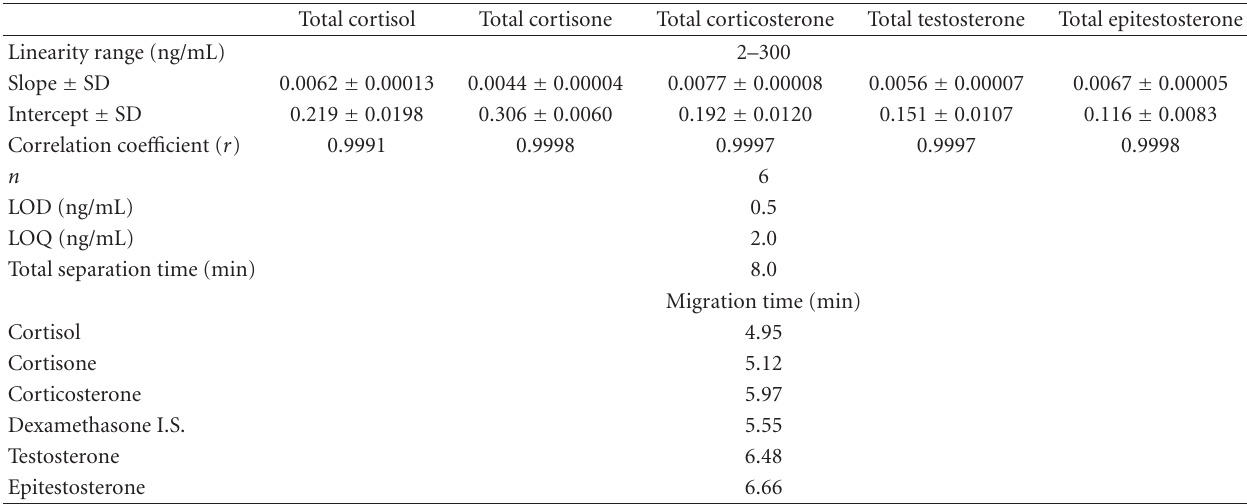
Table 2: Results of regression model for the analyzed